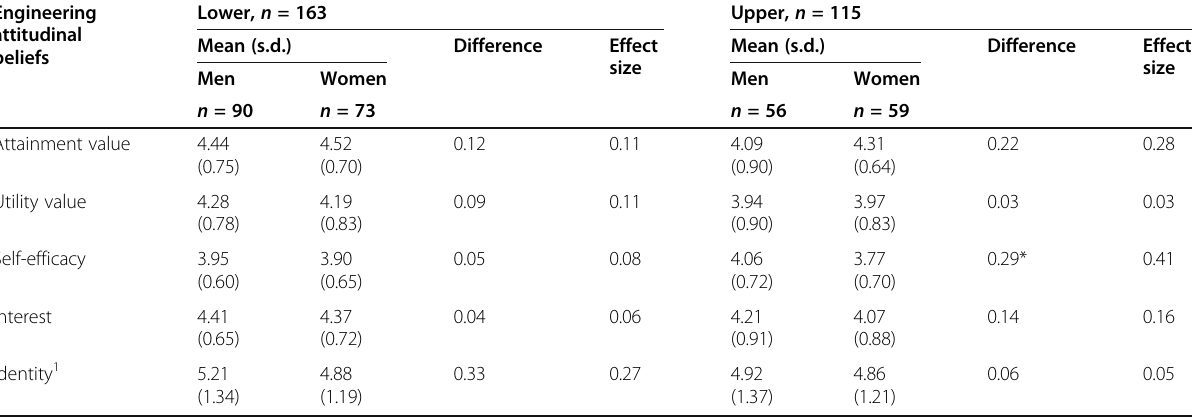
Table 5 Effects of gender for lower and upper division students from RMANOVAs Engineering